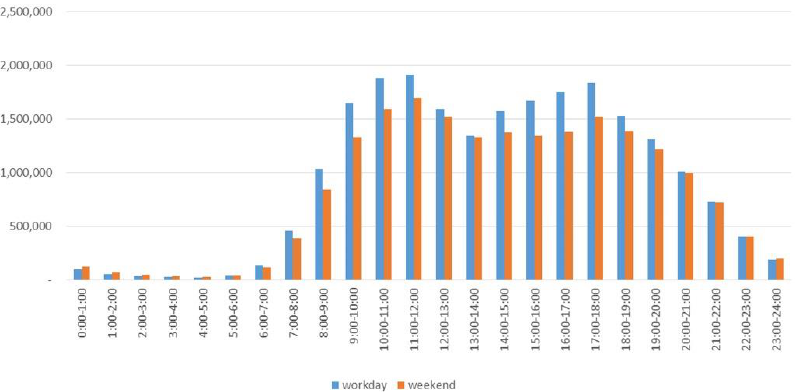
Figure 15. Hourly average distribution of cellular signaling data.